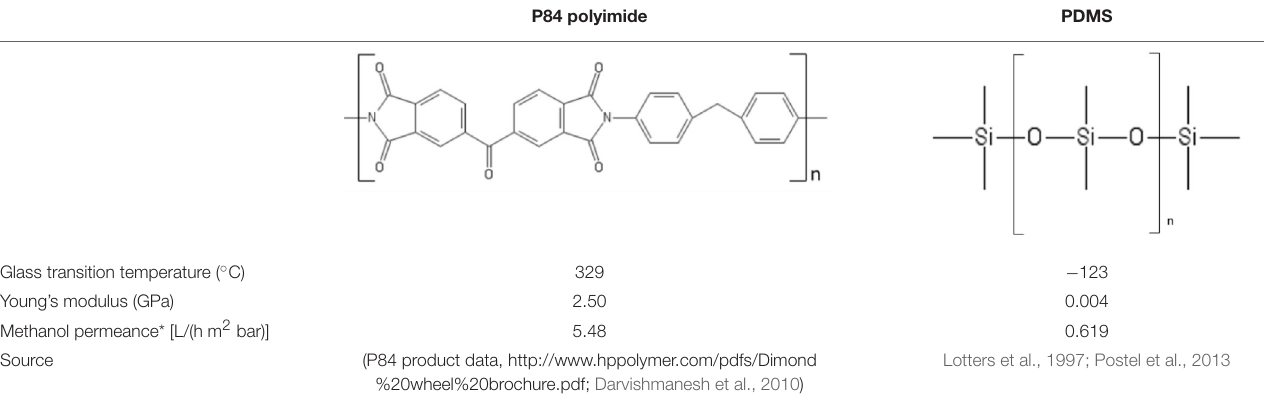
TABLE 1 | Current standard materials for OSN: Lenzing P84 polyimide and